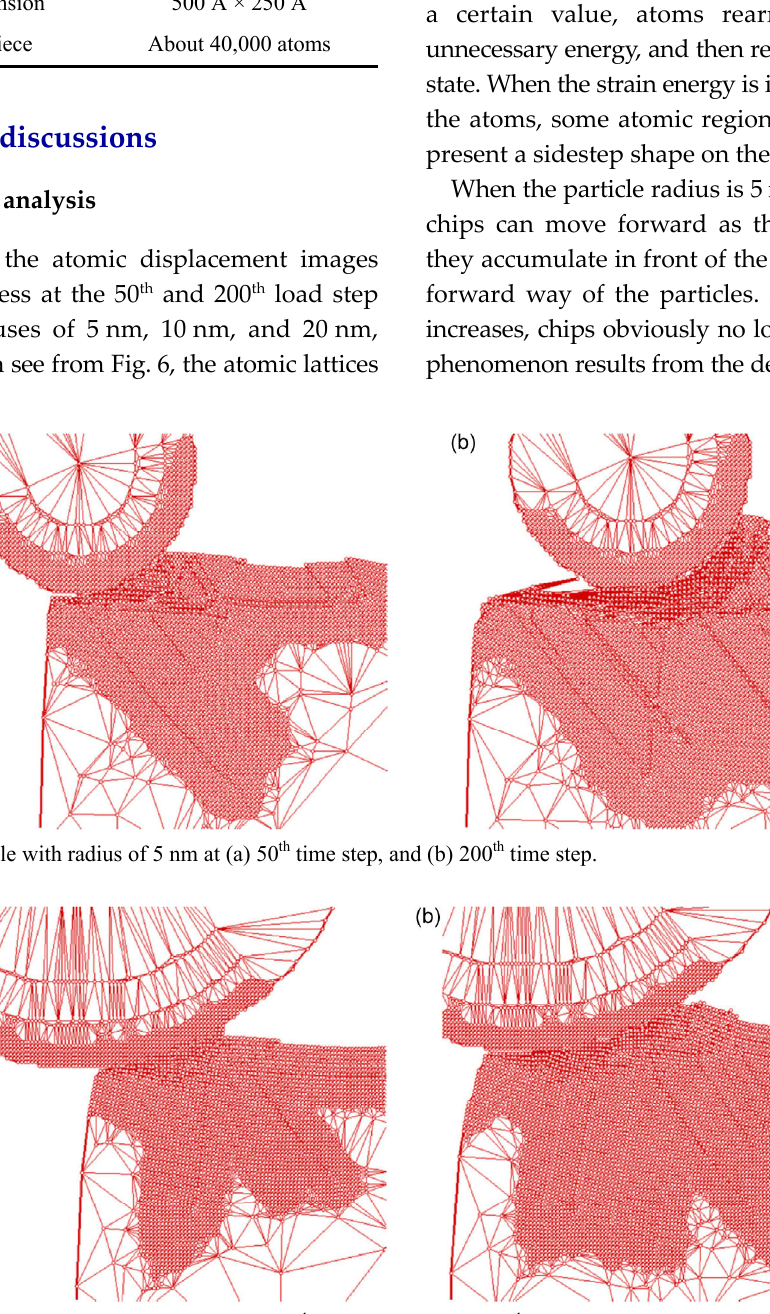
Fig. 7 Abrasive particles with radius of 10 nm at (a) 50 th time step, and (b) 200 th time